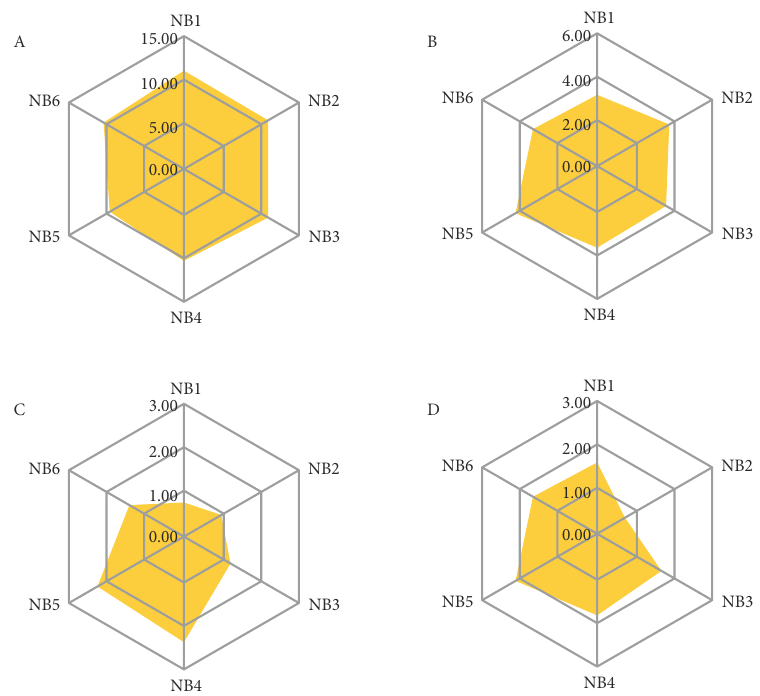
Fig. 1. Illustrated representation of each alternative